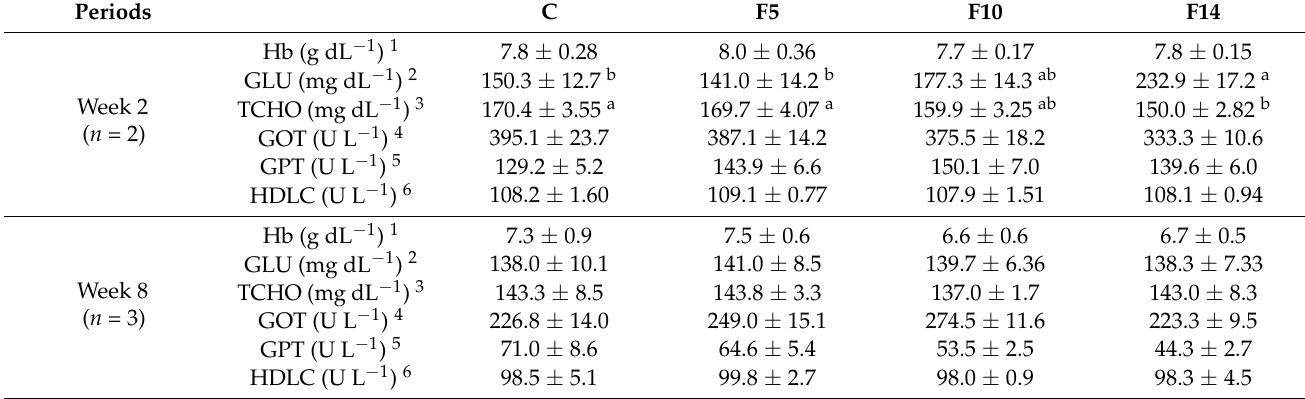
Table 3. Plasma chemical composition of juvenile leopard mandarin fish ( Siniperca scherzeri ) at the end of week 2 and week 8 week in four different feeding groups